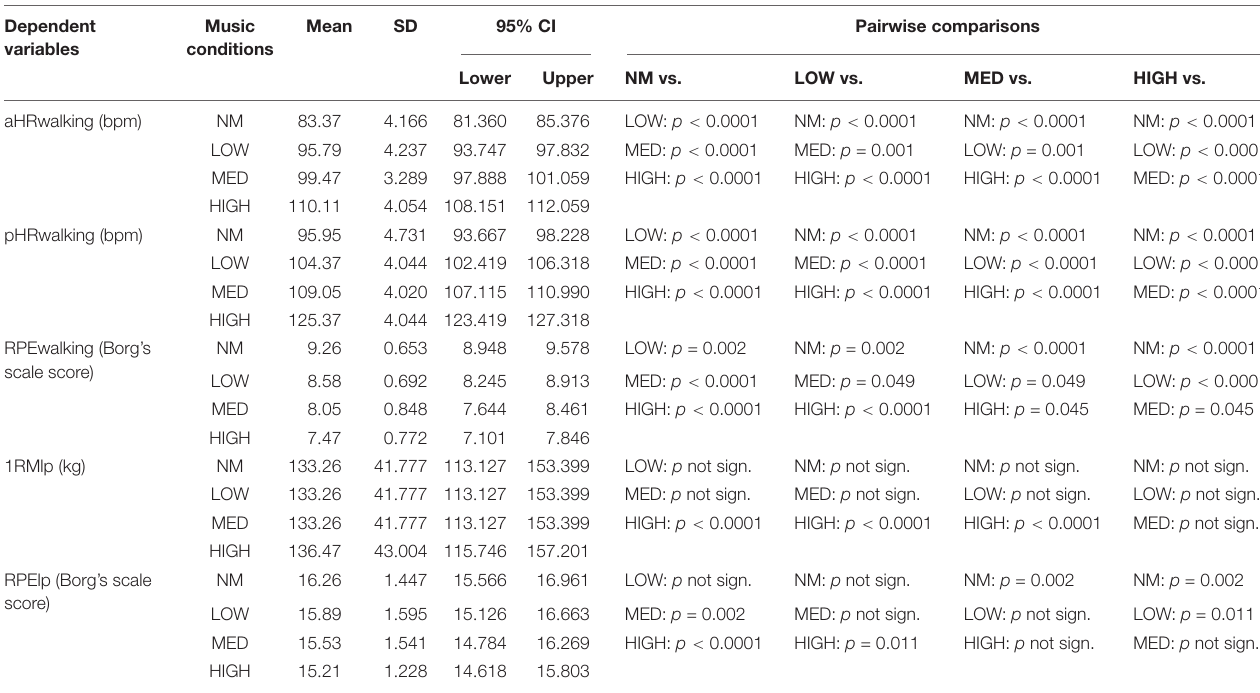
TABLE 2 | Results with pairwise comparisons among the four music